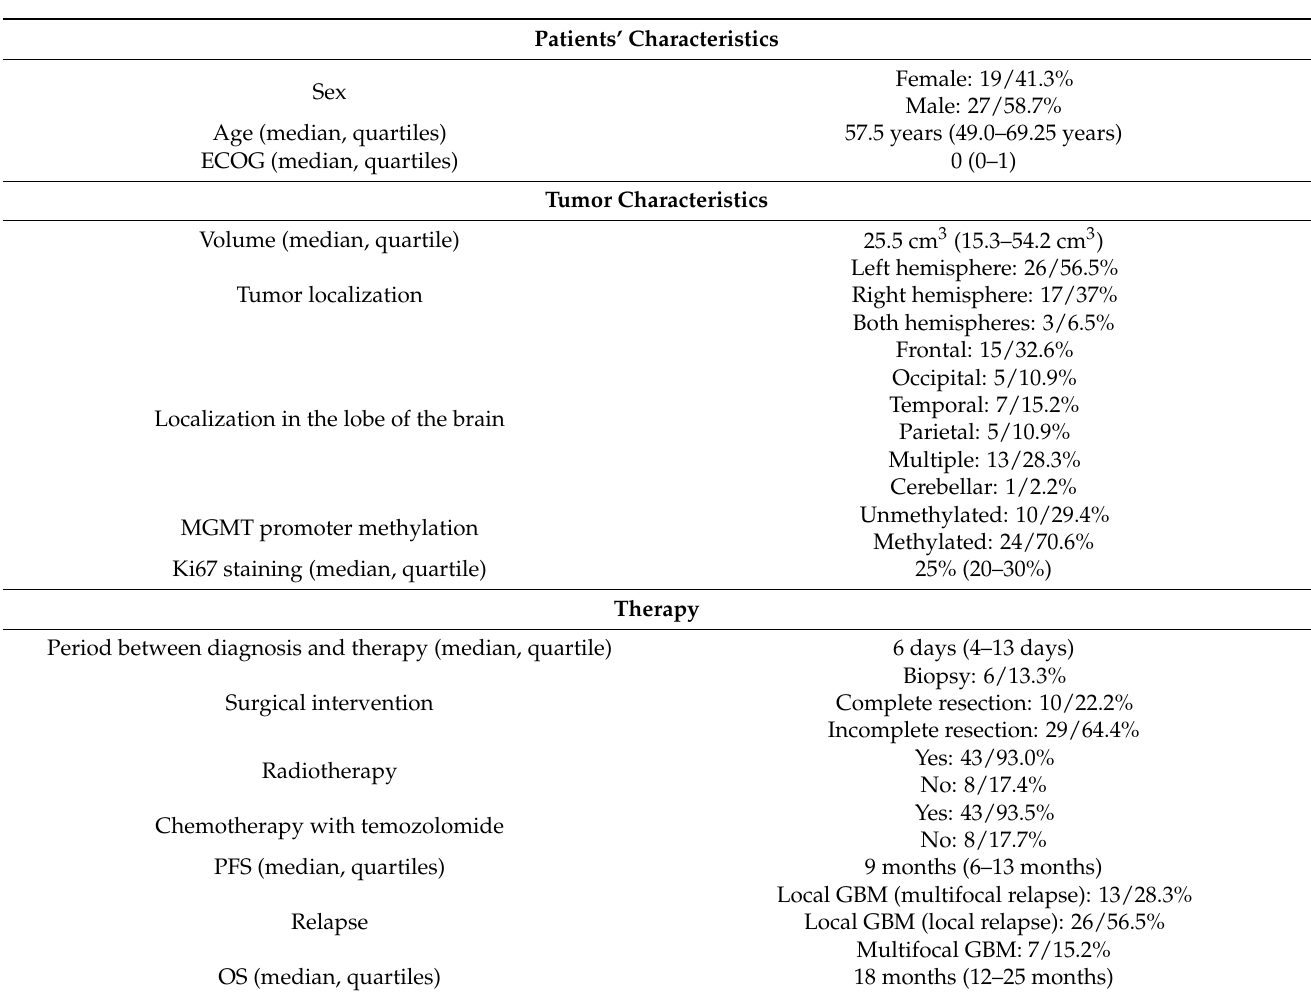
Table 1. Clinical parameters of glioblastoma IDH wild type, CNS WHO grade 4 (GBM) patients ( n =